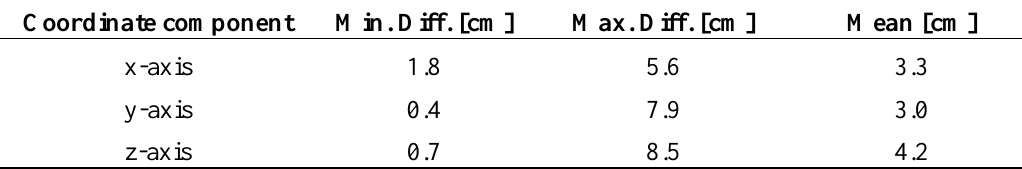
Table 3. Differences in coordinate components in Case 3.